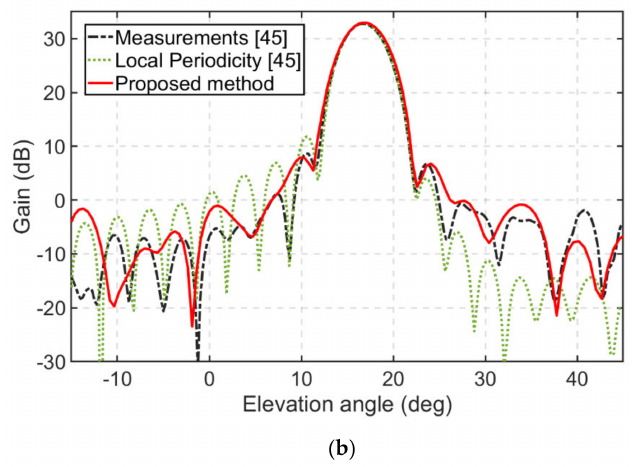
Figure 8. Radiation patterns in elevation plane for X-polarization ( a ) and Y-polarization ( b ) for a focused beam reflectarray antenna based on two stacked orthogonal sets of three parallel dipoles at 11.95 GHz designed in [45]. The numerical results obtained with the proposed method for 4096 × 4096 equi-spaced mesh are compared with a local periodicity approach and measurements shown in